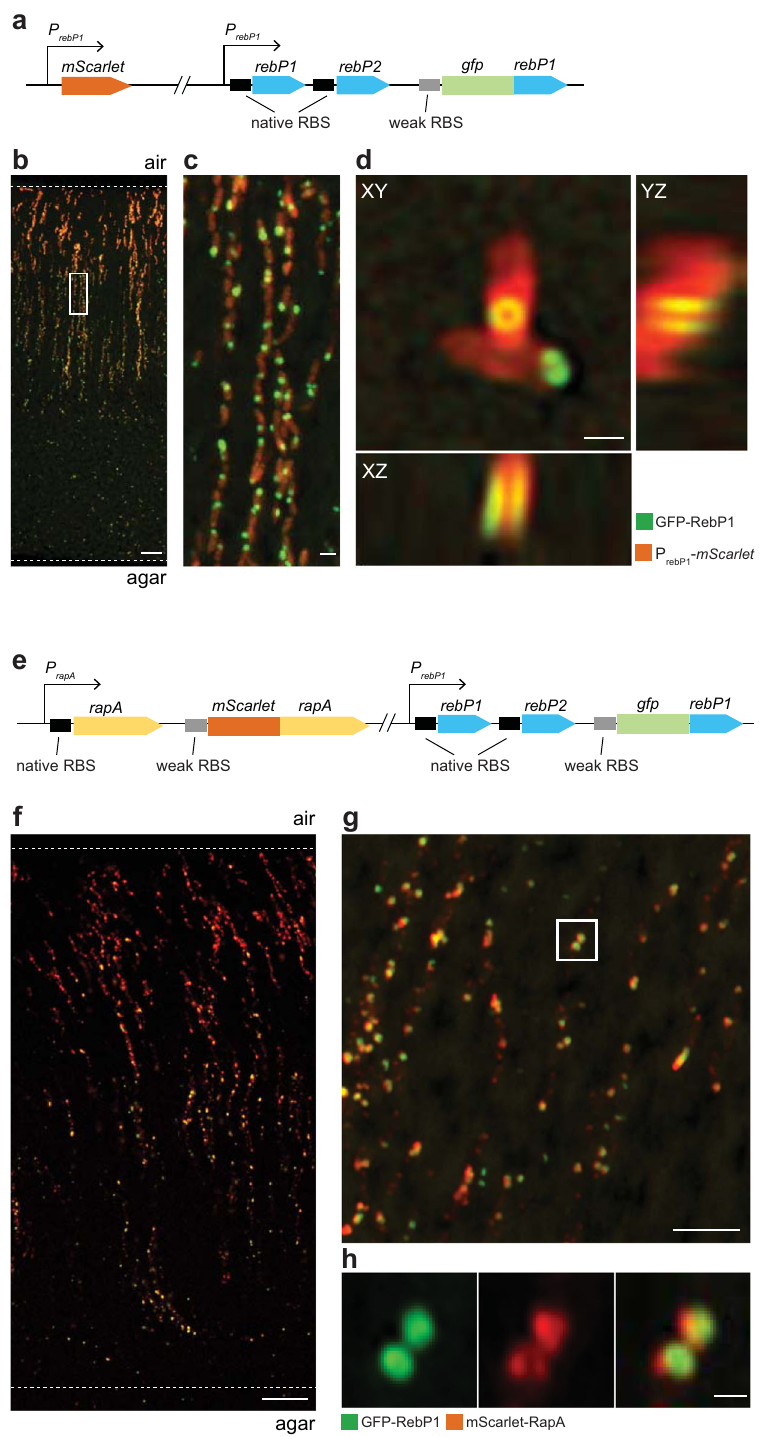
Fig. 4 RebP1 forms internal rings and co-localizes with RapA. a Schematic of constructs present in the strain engineered to produce GFP-tagged RebP1, showing the P rebP1 - mScarlet transcriptional reporter and the gfp-rebP1 translational fusion. b Representative confocal image of a thin section prepared from a 3-day- old bio fi lm formed by the strain indicated. Dotted lines demarcate the edges of the bio fi lm. Scale bar is 10 µ m. c Higher-magni fi cation image of the boxed region shows R-bodies within each cell. Scale bar is 1 µ m. d Zooming in on single cells reveals fl uorescently tagged R-bodies forming a characteristic ring structure. Orthogonal projections reveal the tubular open organization of GFP-RebP1. Scale bar is 500nm. Note that the non-isotropic resolution slightly deforms the structure along the z axis. e Schematic of constructs present in the strain engineered to produce GFP-tagged RebP1 and mScarlet-tagged RapA, showing the gfp-rebP1 translational fusion and the mScarlet-rapA translational fusion. f Representative confocal image of a thin section prepared from a 3-day-old bio fi lm formed by the strain indicated. Dotted lines demarcate the edges of the bio fi lm. Scale bar is 10 µ m. g Super-resolution imaging reveals colocalization of mScarlet-RapA with the R- body ring structure formed by GFP-RebP1. Scale bar is 5 µ m. h Zoom-in of the boxed region shown above. Scale bar is 500nm. Images are representative of three fi elds of view from two